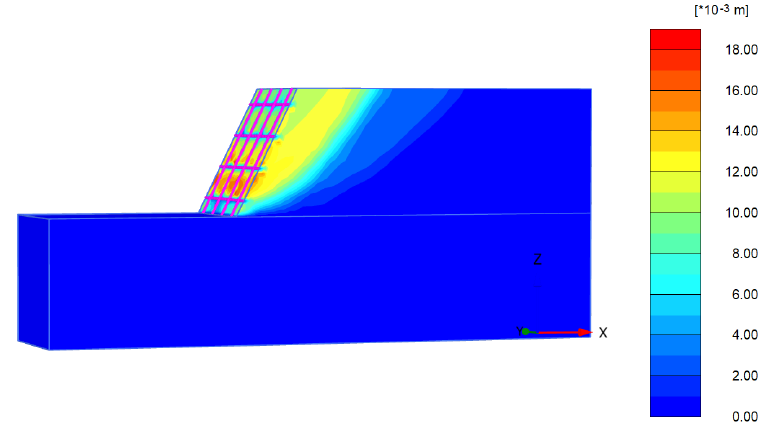
Figure 20. Total displacement increment cloud map of 1:0.5 model.